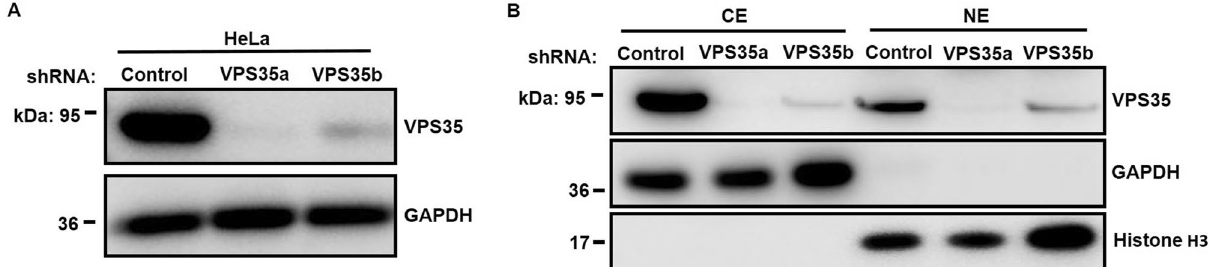
Figure 1. Validation of nuclear protein enrichment from HeLa stable cell lines. ( A ) Lysate prepared from cells stably transduced with specific lentiviral shRNAs (denoted a and b) or scrambled control was subjected to western blotting to examine the efficient knockdown of endogenous VPS35 in HeLa cells. ( B ) Cytosolic (CE) and nuclear extracts (NE) of HeLa cells stably expressing the indicated shRNA were analyzed by western blotting. GAPDH and histone H3 were used as cytoplasmic and nuclear markers,